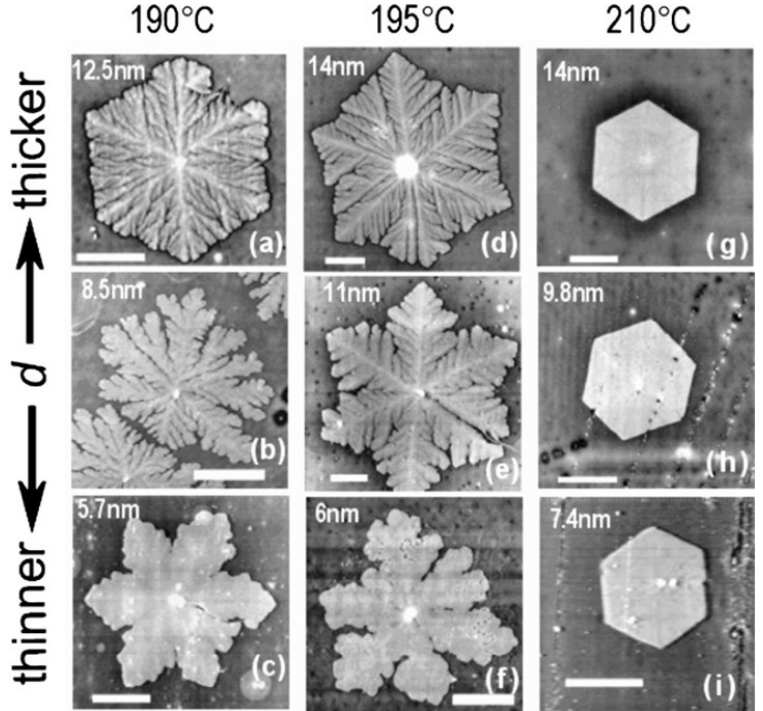
Figure 7. AFM images of crystals grown from ultrathin films of iPS at different temperatures and sample thicknesses. Reproduction with copyright permission from Elsevier, Prud’homme R.E [137].